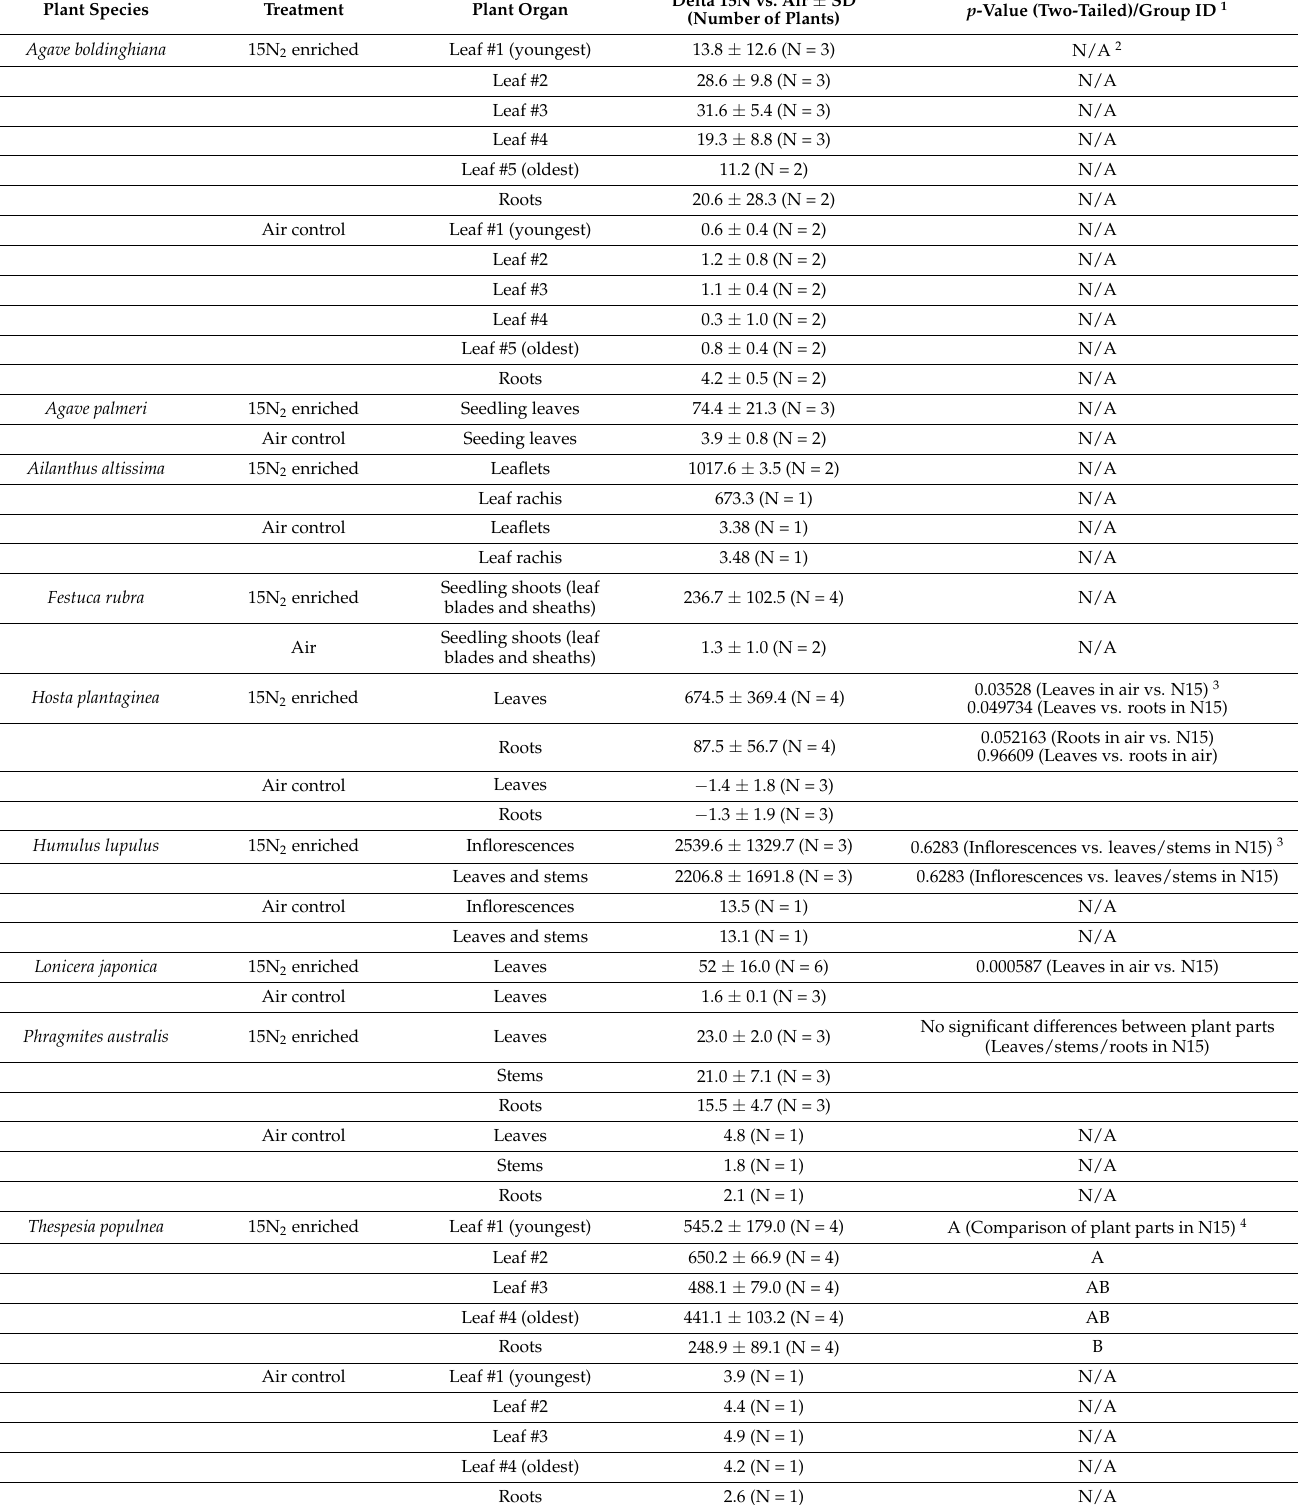
Table 2. Results of 15 N assimilation experiments for Agave boldinghiana , Ailanthus altissima , Hosta plantaginea , Humulus lupulus , Phragmites australis , Thespesia populnea , and Vanilla phaeantha